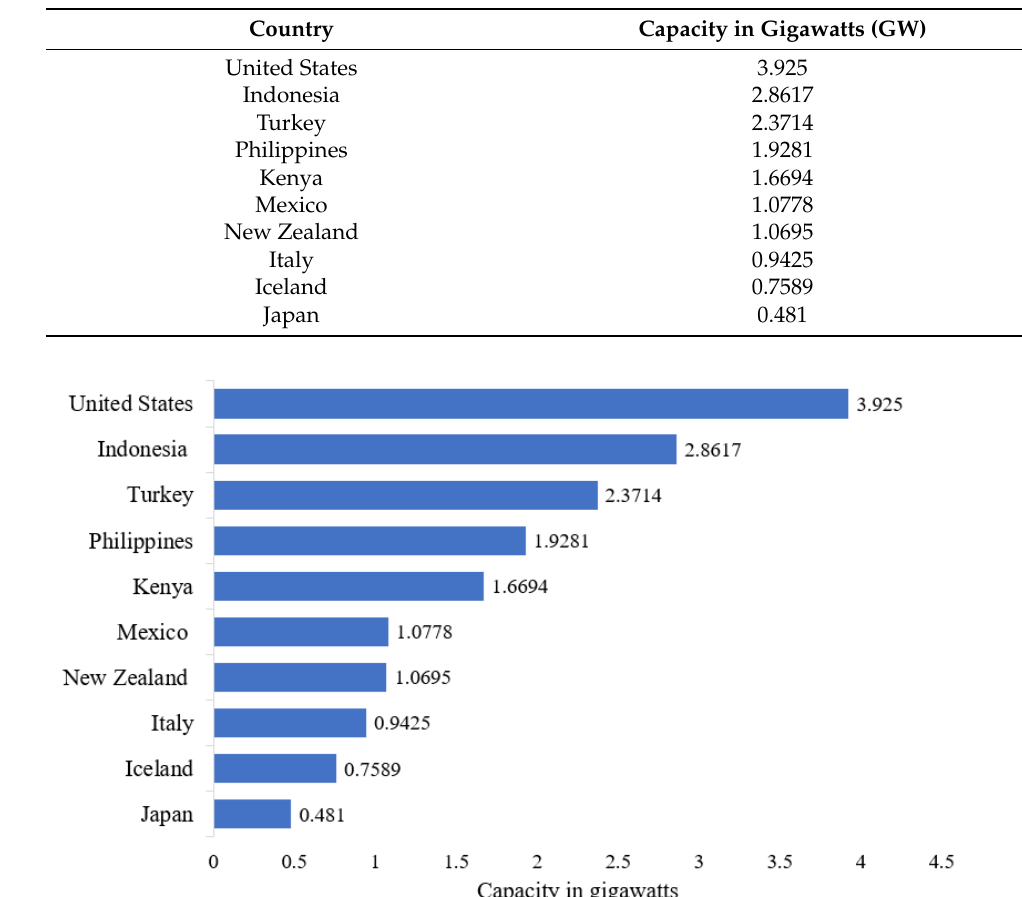
Figure 4. Geothermal energy installation capacity prediction for the top 10 countries utilizing geothermal energy in 2030 using the IGM (1,1)